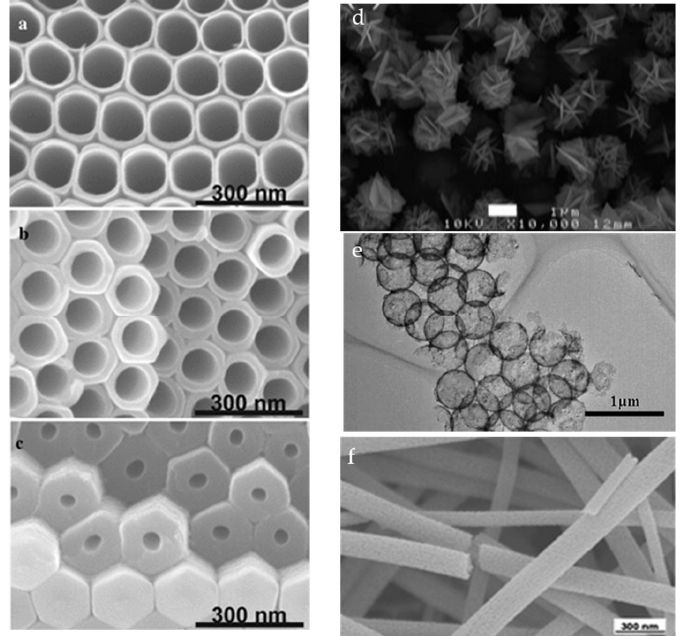
Figure 2. Scanning Electron Microscope(SEM) images of TiO 2 nanotubes taken from the upper part of the layer ( a ), the middle of the layer ( b ), and the bottom of the layer ( c ), reprinted with permission from [70]. ( d ) SEM images of flower TiO 2 reprinted with permission from [72], ( e ) Transmission Electron Microscope (TEM) image of TiO 2 hollow spheres reprinted with permission from [68]. ( f ) SEM images of TiO 2 nanobelts reprinted with permission from